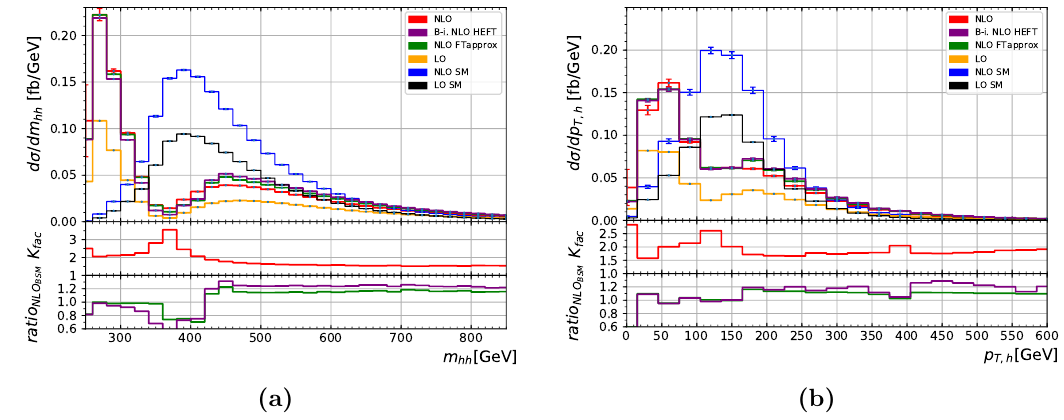
Figure 18. Same as (cid:12)gure 12 but for benchmark point 6, c hhh = 2 : 4 ; c t = 1 ; c tt = 0 ; c ggh = 2 = 15 ; c gghh = 1 = 15.